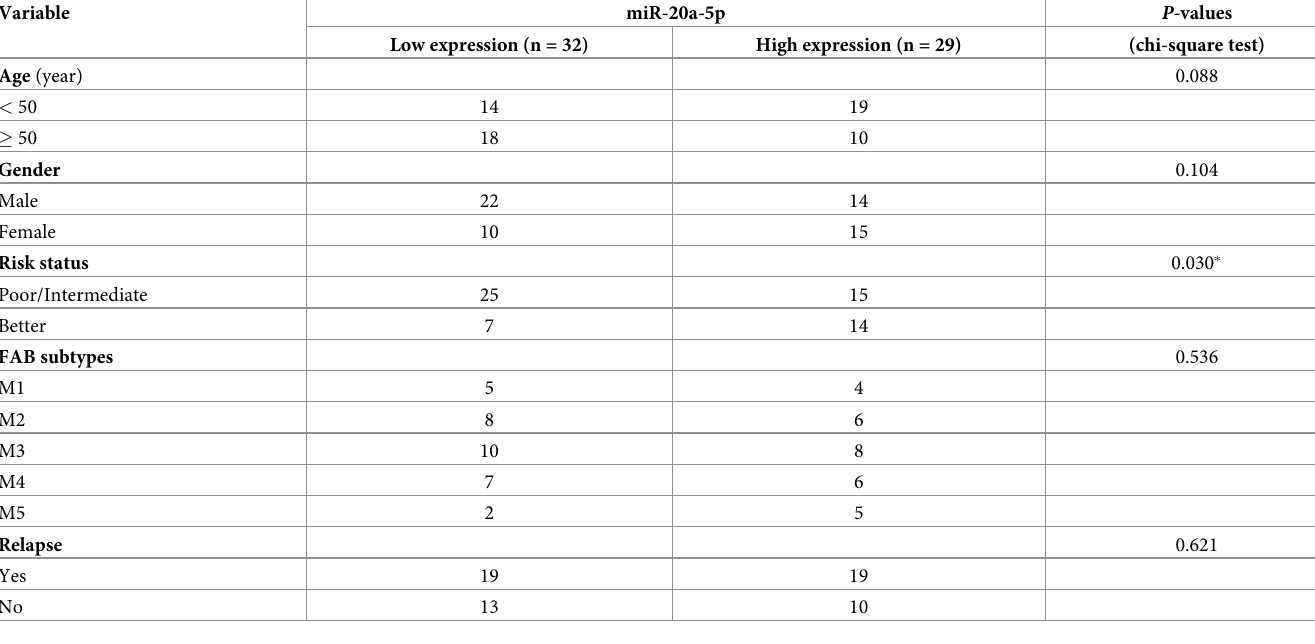
Table 1. The association between miR-20a-5p expression levels and clinicopathological variables of AML patients. Variable miR-20a-5p P -values Low expression (n = 32) High expression (n = 29) (chi-square